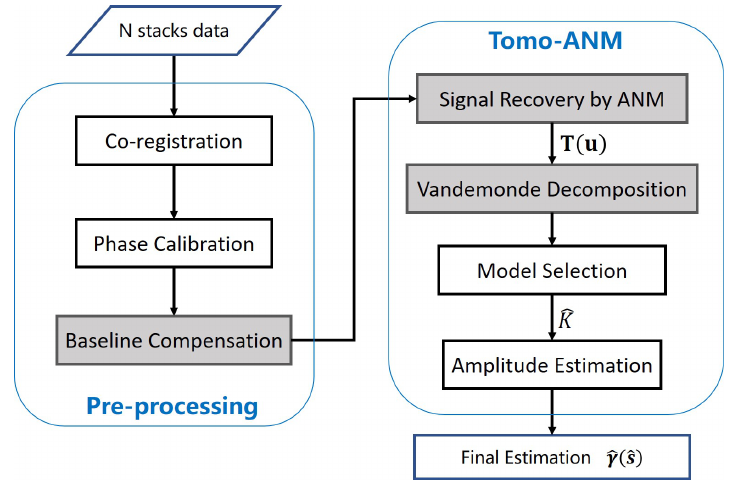
Figure 2. Flowchart of the proposed method.